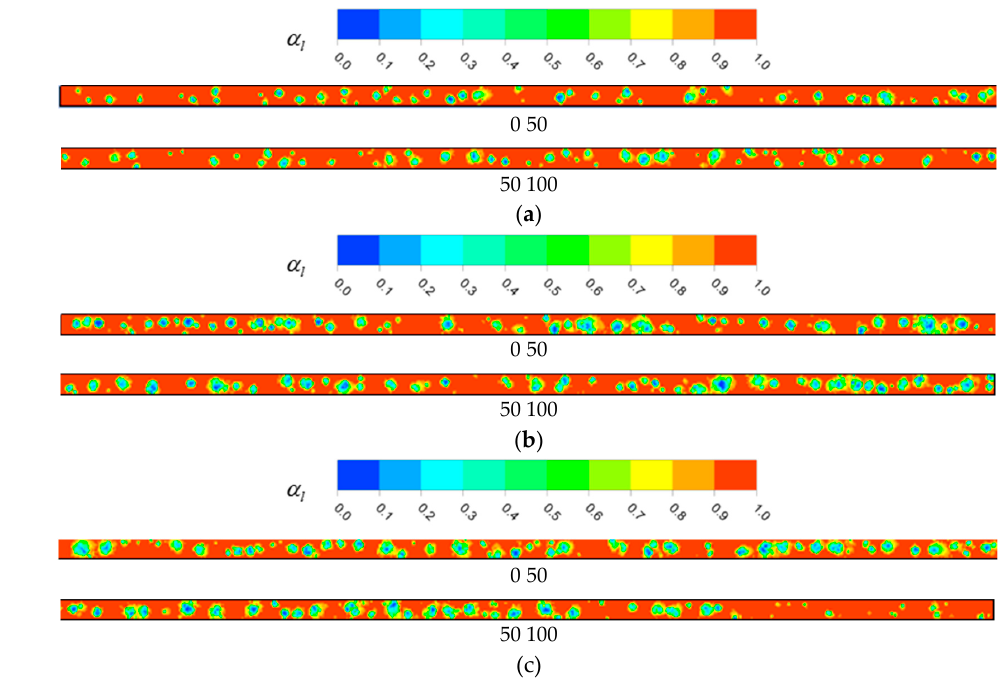
Figure 8. Volume fraction distribution of az-refrigerant liquid phase at different heat fluxes: ( a ) T sat = 253 K, G = 50 kg/m 2 · s, q = 10 kW, X = 0.26; ( b ) T sat = 253 K, G = 50 kg/m 2 · s, q = 20 kW, X = 0.52; ( c ) T sat = 253 K, G = 50 kg/m 2 · s, q = 30 kW, X = 0.78.